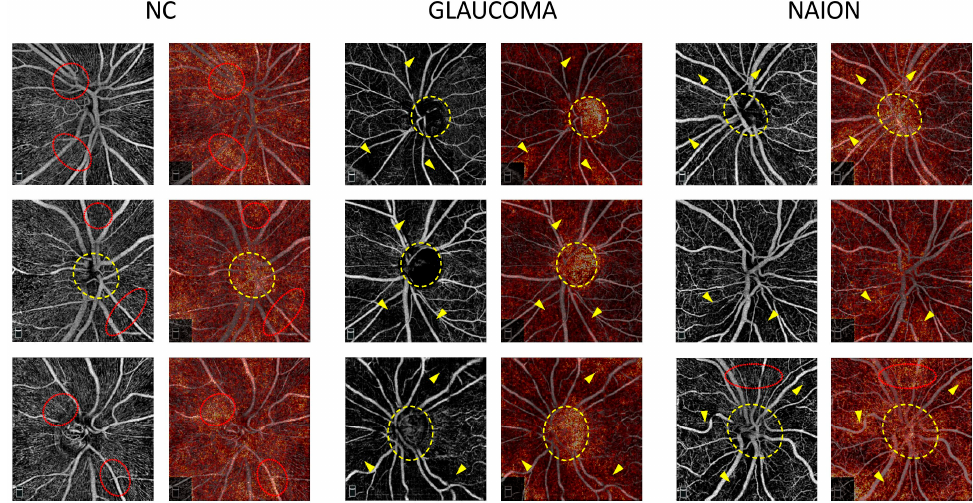
Figure 2. Examples of radial peripapillary capillaries plexus (RPC) attribution maps. RPC optical coherence tomography angiography (OCTA) for glaucoma, non-arteritic anterior ischemic optic neuropathy (NAION) and normal control (NC) correct attributions ( left column ) are represented with the corresponding attribution maps ( right column ). On the NC attribution maps, the most heavily highlighted areas correspond to the high vessel density areas on the OCTA image (red dotted circles) and in some cases to the optic nerve head (yellow dotted circle). On the glaucoma and NAION attribution maps, hot spots overlap the low vessel density areas (yellow arrows) on the OCTA image and the optic nerve head (yellow dotted circle). Areas with a preserved microvasculature (red dotted circle) can also be emphasized on the NAION attribution maps.